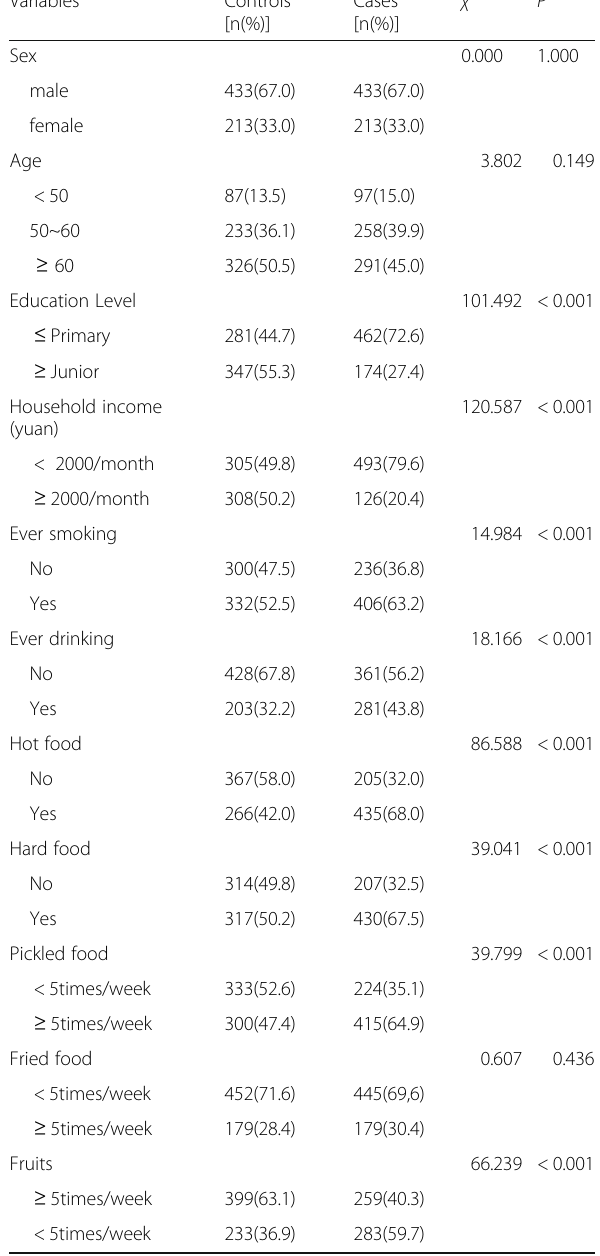
Table 1 The characteristics of cases and